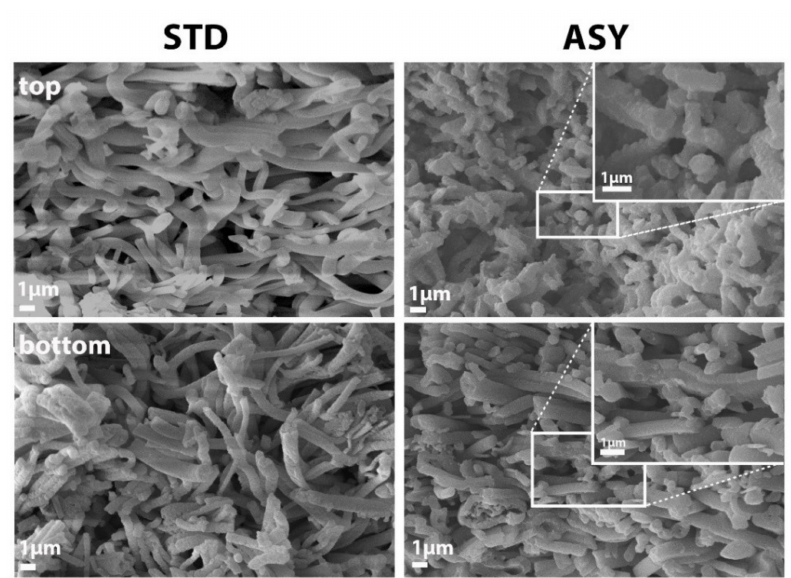
Figure 7. Comparative SEM micrographs of the ( top ) and ( bottom ) fractured surfaces of Y-ZTA samples fabricated in STD and ASY graphite arrangements at a 1300 ◦ C sintering temperature.